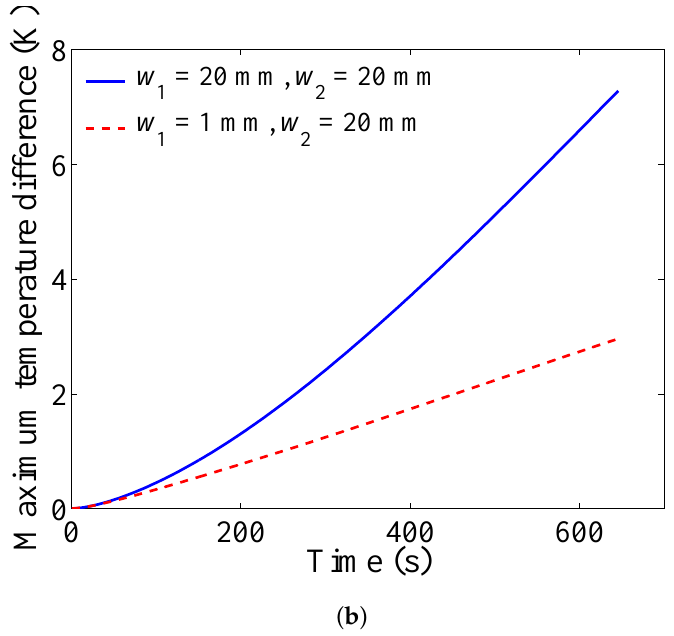
Figure 12. Comparison of the maximum temperature and the maximum temperature difference of the battery pack with time with fixed power consumption. ( a ) Maximum temperature; ( b ) maximum temperature